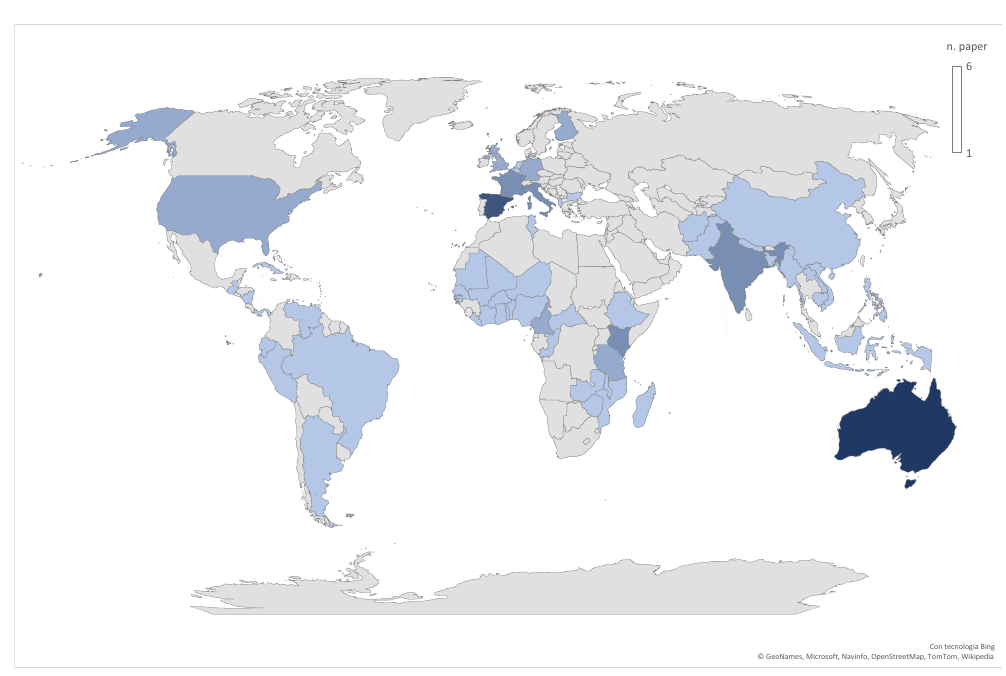
Figure 5. Countries where the selected studies were conducted. (Source: our elaboration.)